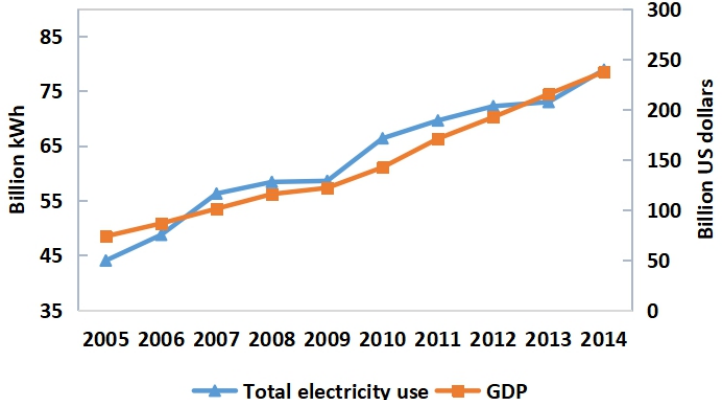
Figure 3. Local electricity generation and its proportion to total electricity use in Shenzhen during 2005–2015.